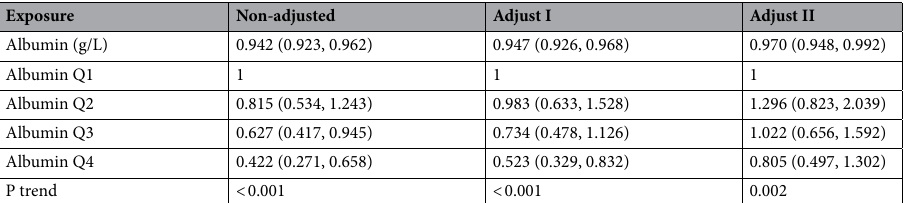
Table 2. The relationship between serum albumin and coronary heart disease risk. Independent variable: serum albumin; dependent variable: coronary heart disease. Results are expressed as OR (95% CI). Serum albumin grouping standard: Q1: < 35; Q2: > = 35, < 40; Q3: > = 40, < 45; Q4: > = 45. Non-adjusted model adjust for: None. Adjust I model adjust for: Gender; Age; Race. Adjust II model adjust for: Gender; Age; Race; Diabetes; HDL-C; Hypertension; LDL-C; Creatinine.